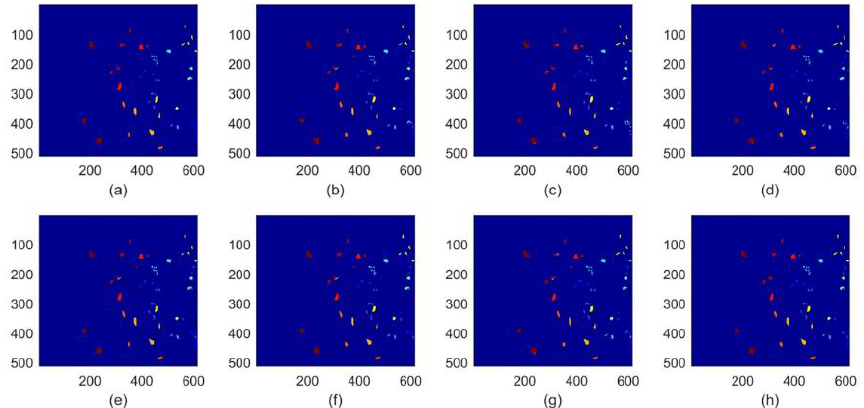
Figure 6. Classification maps for KSC. ( a ) Ground truth, ( b ) BH, ( c ) LDFA, ( d ) LPP, ( e ) NWFE, ( f ) PCA, ( g ) SH, ( h ) the proposed SDHE. The different colors indicate the different classes.